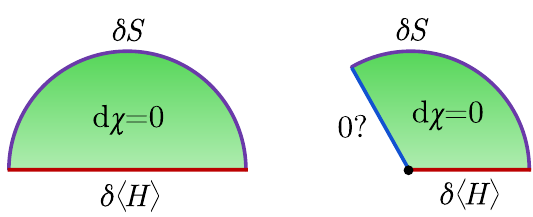
Figure 3. Left . The (cid:12)rst law from Stokes theorem in AdS/CFT. Right . For AdS/BCFT, the (cid:12)rst law requires that the contribution from the brane